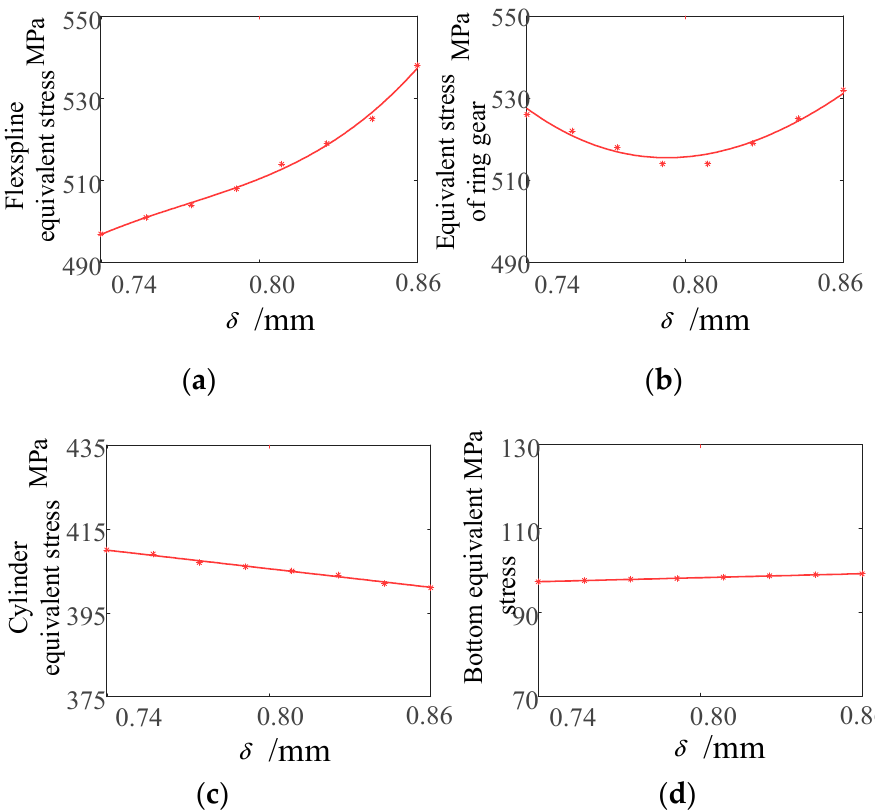
Figure 21. Stress influence curve of the different smooth cylinder wall thickness of the flexible wheels. ( a ) Stress variation curve of the flexspline; ( b ) Stress change curve of the ring gear; ( c ) Cylinder stress change curve; ( d ) Bottom stress variation curve.